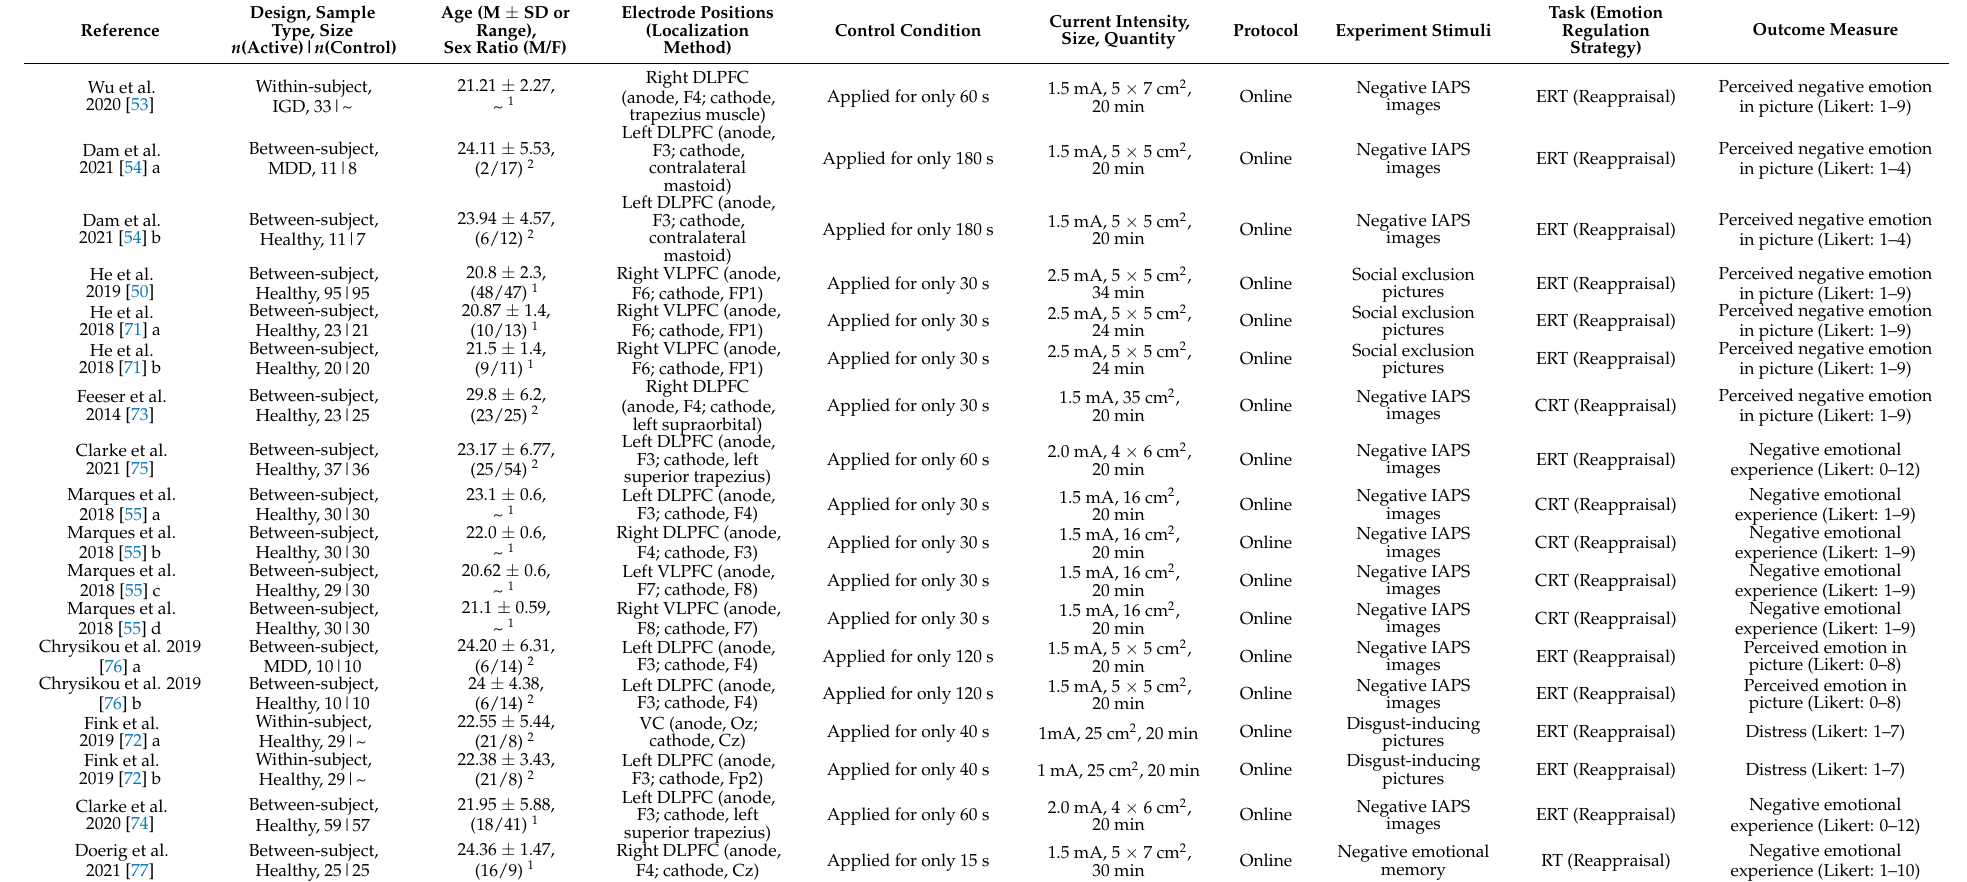
Table 2. Characteristics of included anodal transcranial direct current stimulation studies.